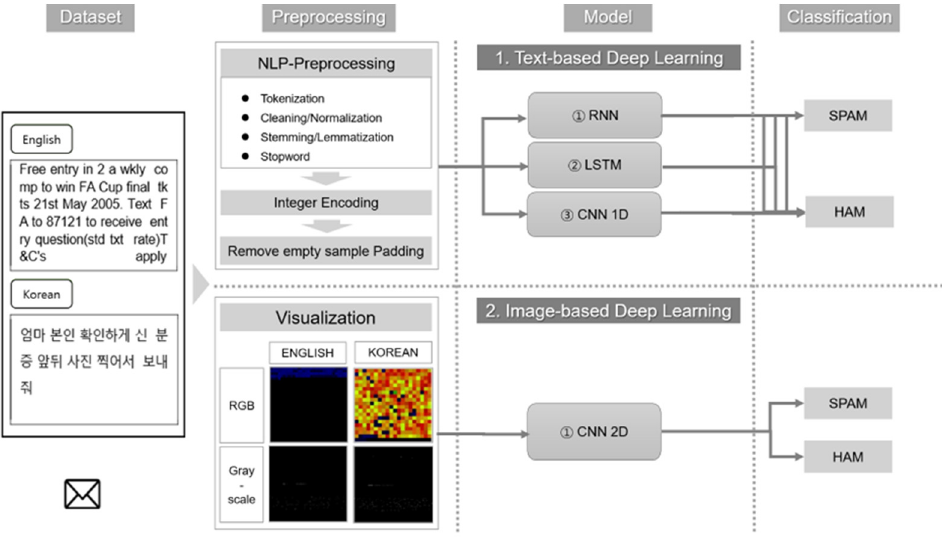
Figure 1. General description of proposed spam detection methods. Table 2. Dataset